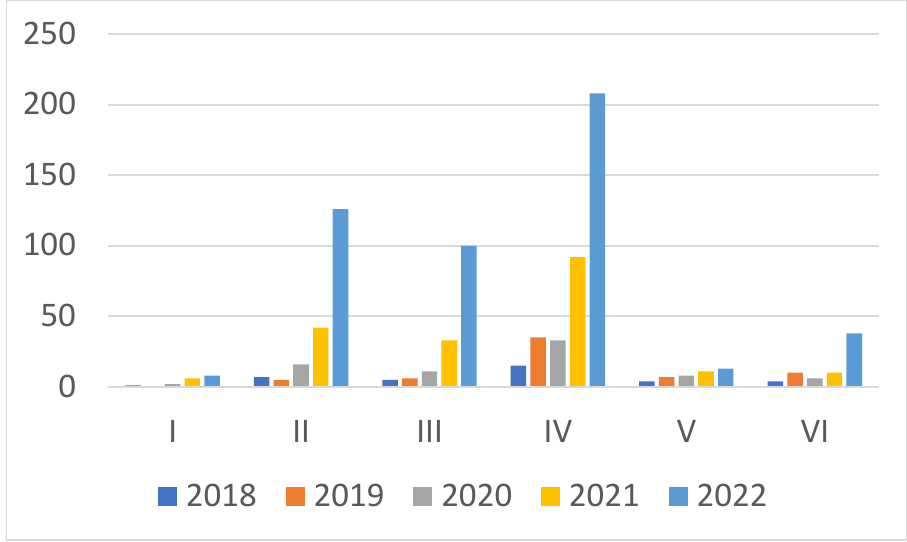
Figure 7. Evolution of scientific articles number related to hydrogen production from seawater electrolysis by search of different key words (I – VI).